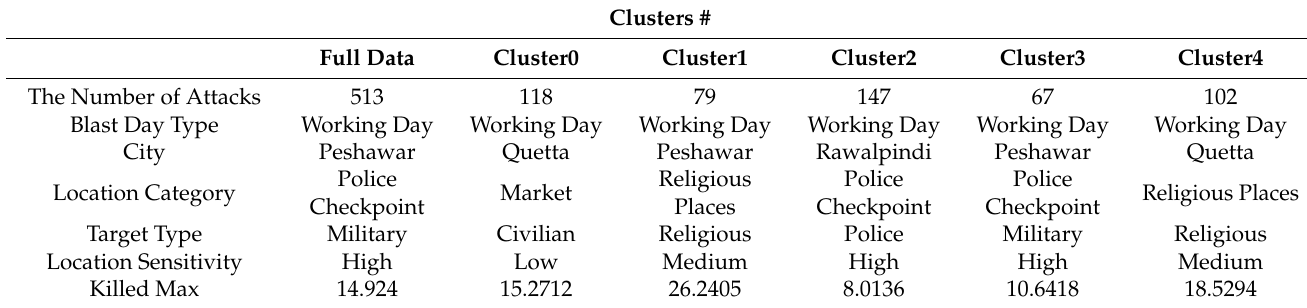
Table 5. K-means clustering results for K = 5.